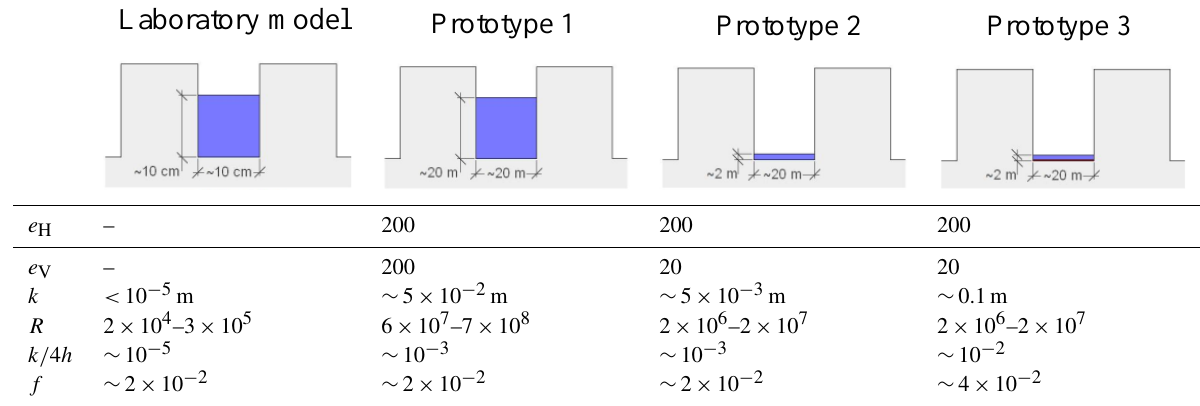
Table 5. Characteristic Reynolds number R , roughness height k and Darcy–Weisbach coefficient f on the laboratory model scale and at the prototype scale (real-world) as a function of the horizontal and vertical magnification factors e